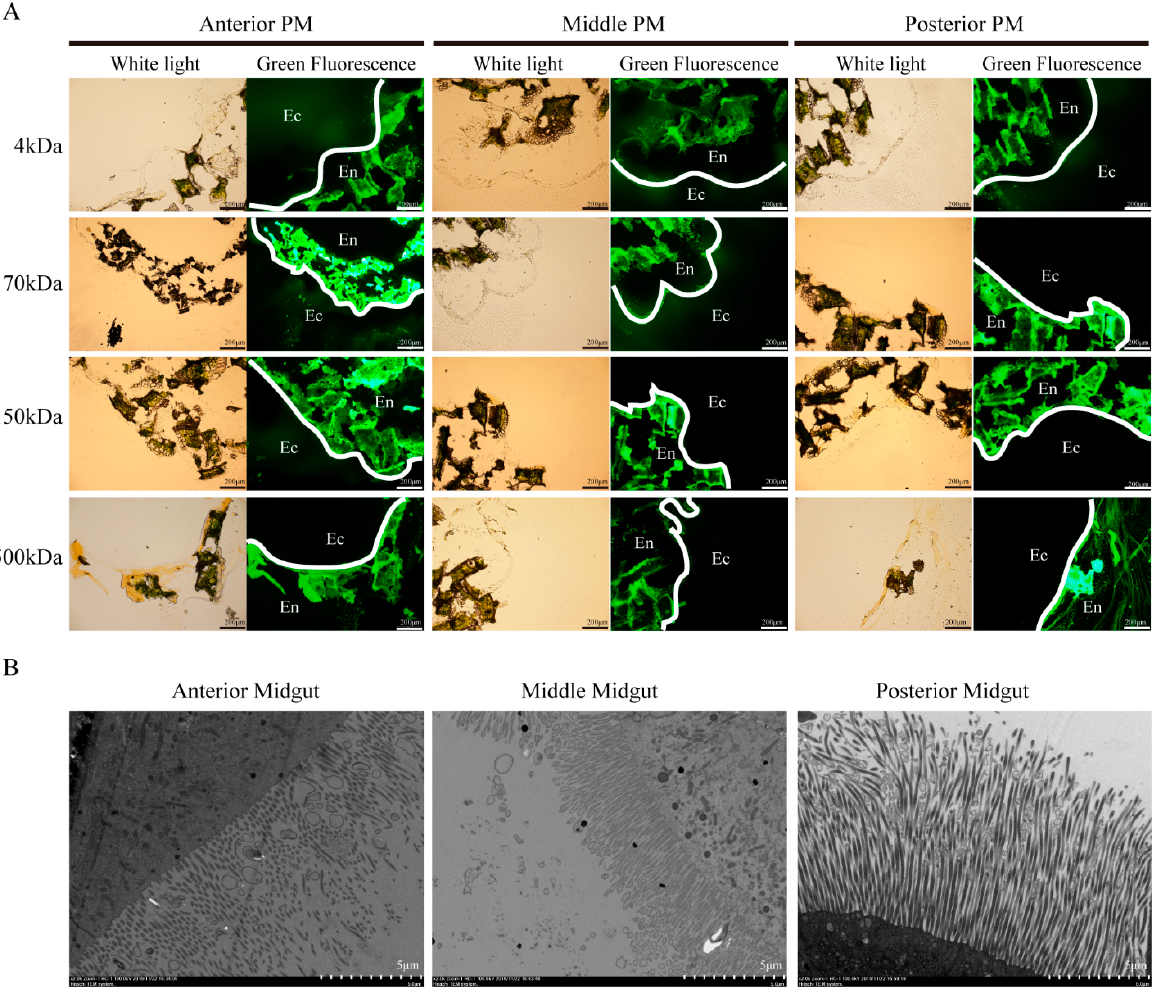
Figure 1. Peritrophic matrix (PM) permeability and microvilli morphology of silkworms in different regions of the larval midgut. ( A ) Anterior, middle, and posterior PM permeability on the 3rd day of the fifth instar larvae detected using fluoresceine isothiocyanate (FITC)-dextran and fluorescence microscope (100 × ). En, endoperitrophic space. Ec, ectoperitrophic space. White lines indicate the location of the PM. ( B ) Microvilli and secreted vesicles of the anterior, middle, and posterior midgut on the 3rd day of the fifth instar larvae evaluated using transmission electron microscopy (2000 ×